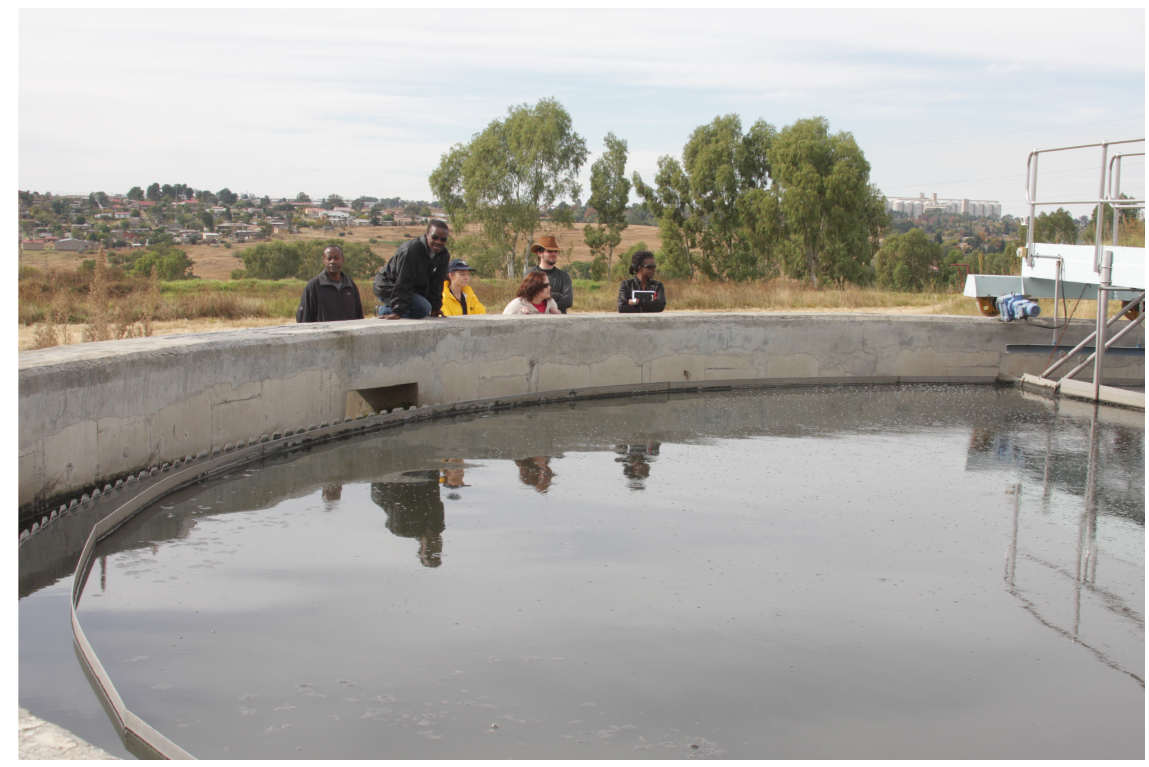
Figure 1 Members of the CuDyWat research team at the wastewater